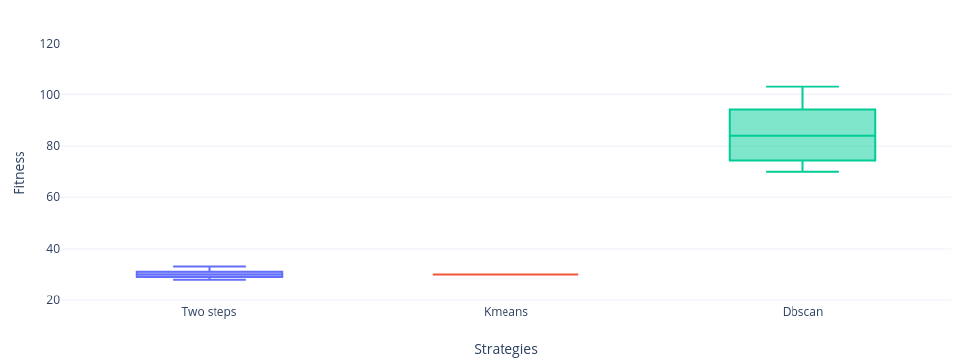
Figure 15. Instance nre.5